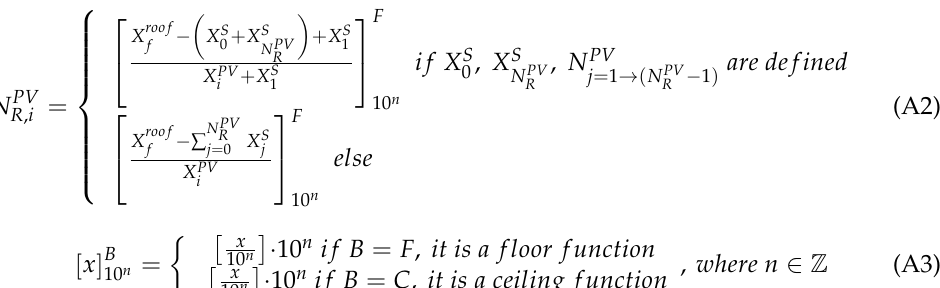
Figure A2. Dimension of a solar panel. Equation (A2) shows the maximum number of solar panels ( N PV ) in a row on the X- axis. Where, X roof is the width of the rooftop; X S is the space on the X-axis between two solar panels; X S is the space between the right boundary and the last solar panel; X PV is the short side length of the solar panel; X S is the space between the left boundary and the first solar panel; [ x ] B is the general round function suggested in this paper and expressed in Equation (A3). For example, [ 235.7235 ] C 100 = [ 2.357235 ] · 100 = 3 · 100 = 300; [ 235.7235 ] C 0.01 = [ 23572.35 ] · 0.01 = 23573 · 0.01 = 235.73.